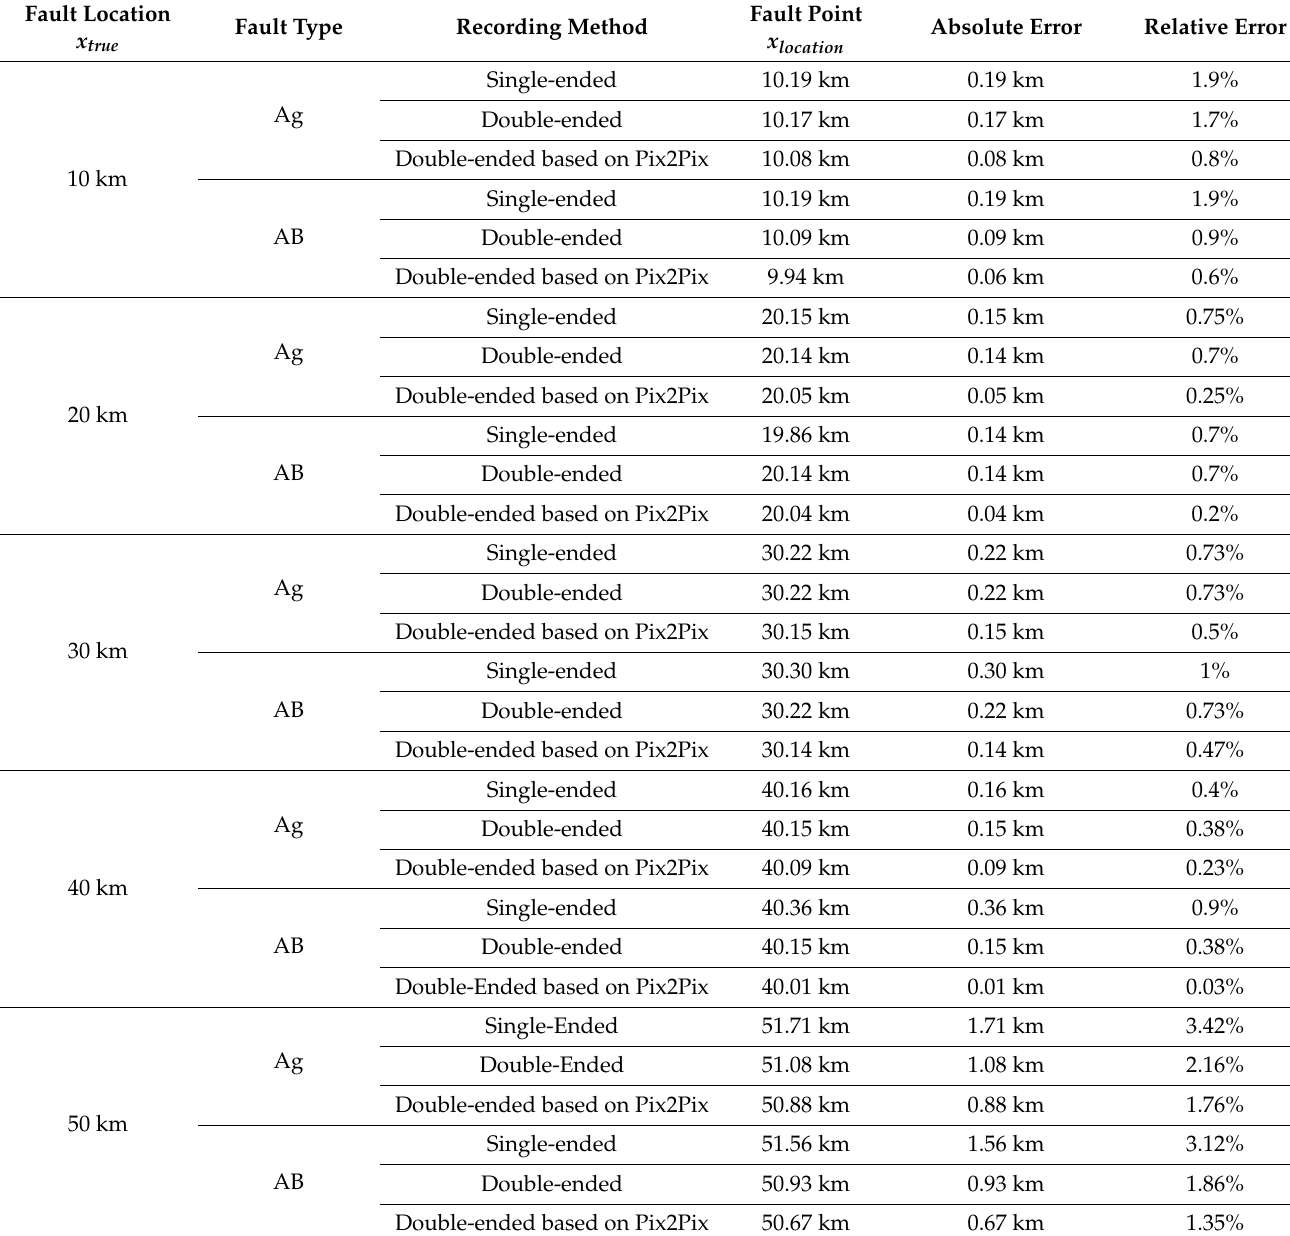
Table 3. Contrast of simulation